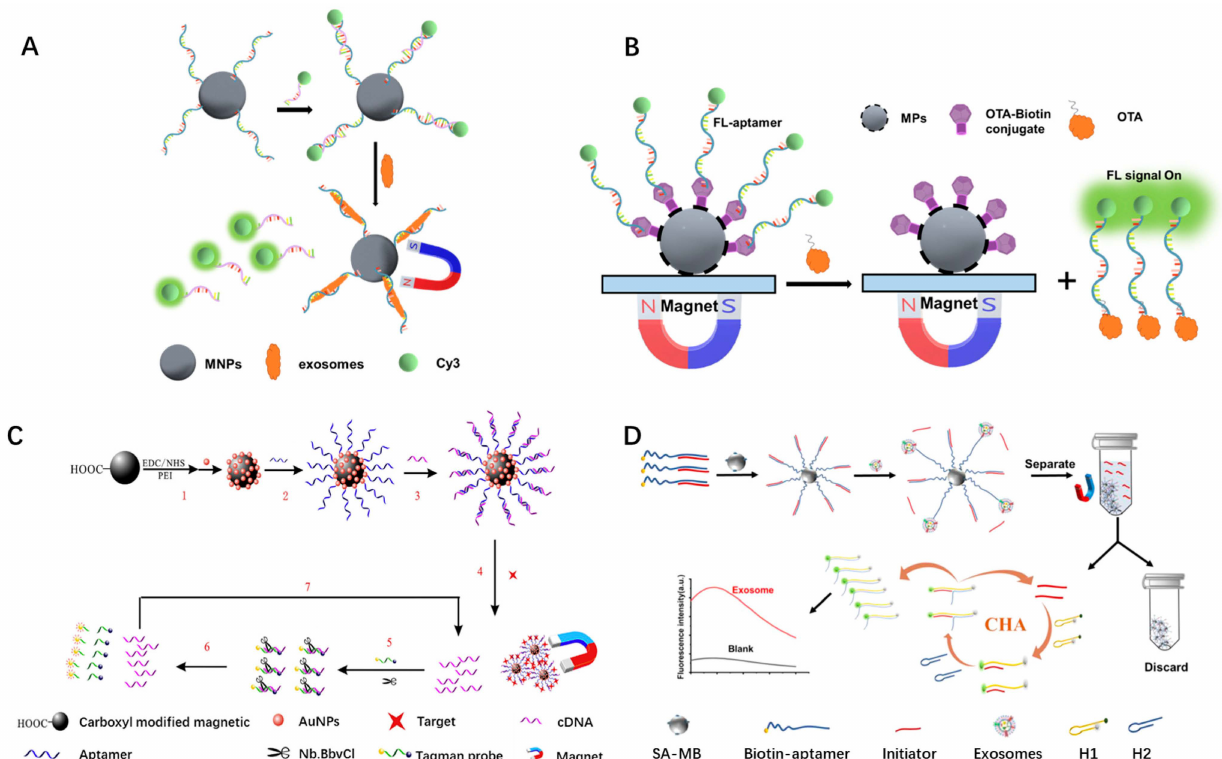
Figure 7. Competitive assay methods via fluorometric apta-biosensing ( A ) The competitive detection of exosomes based on an aptamer specific to the CD63 protein. ( B ) An aptasensor based on an aptamer-modified fluorescent particle for OTA detection. ( C ) Fluorescence signal-amplified strategy and procedure using AuNPs/MPs and a nicking enzyme, reproduced with permission from